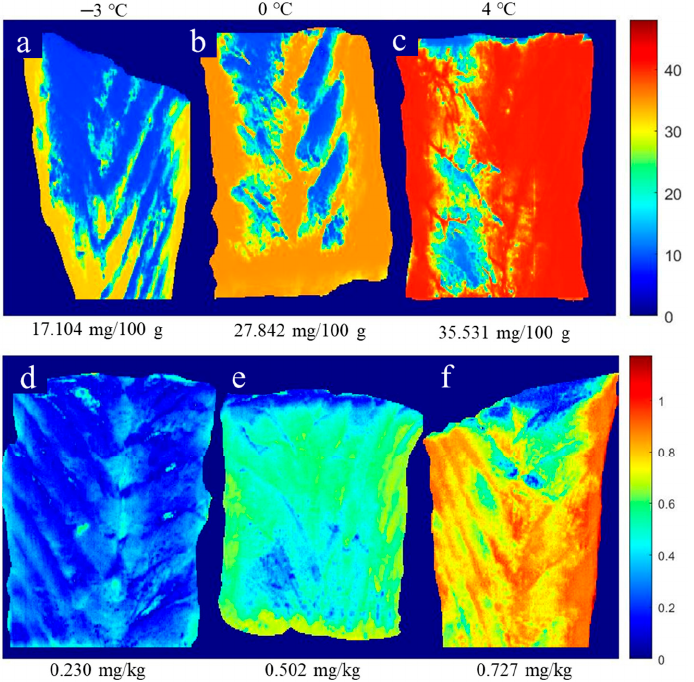
Figure 4. Distribution maps of TVB-N ( a – c ) and TBA ( d – f ) contents in large yellow croaker fillets after 8-day storage at three low-temperature